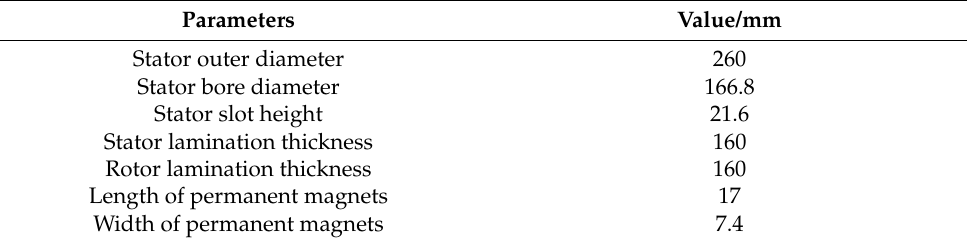
Table 2. Material parameters of PMSM.